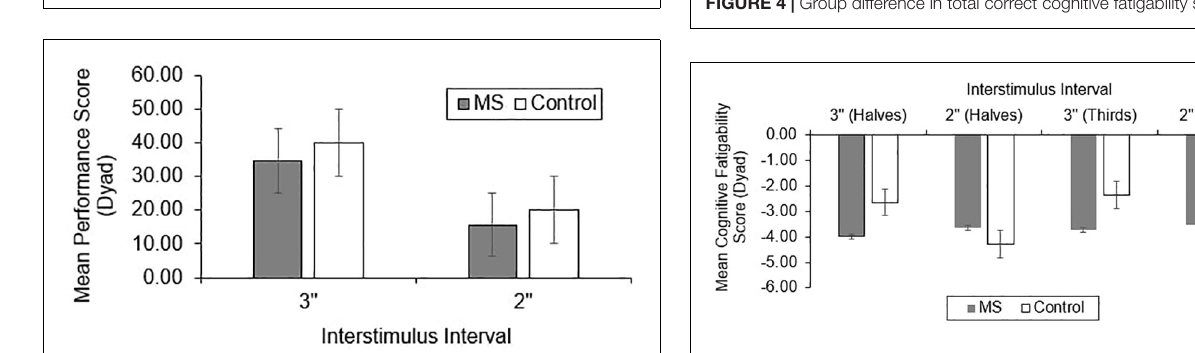
FIGURE 4 | Group difference in total correct cognitive fatigability scores.